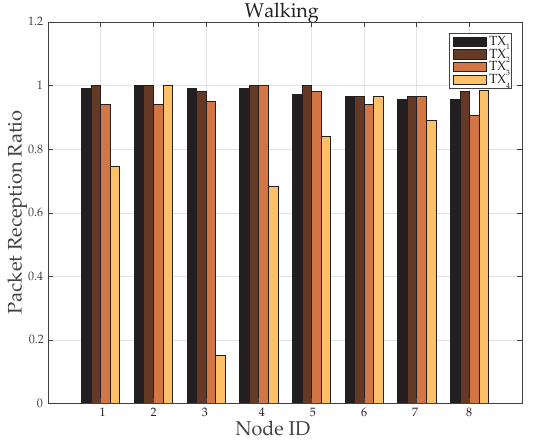
Figure 14. Packet Reception Ratio at various nodes while walking activity.